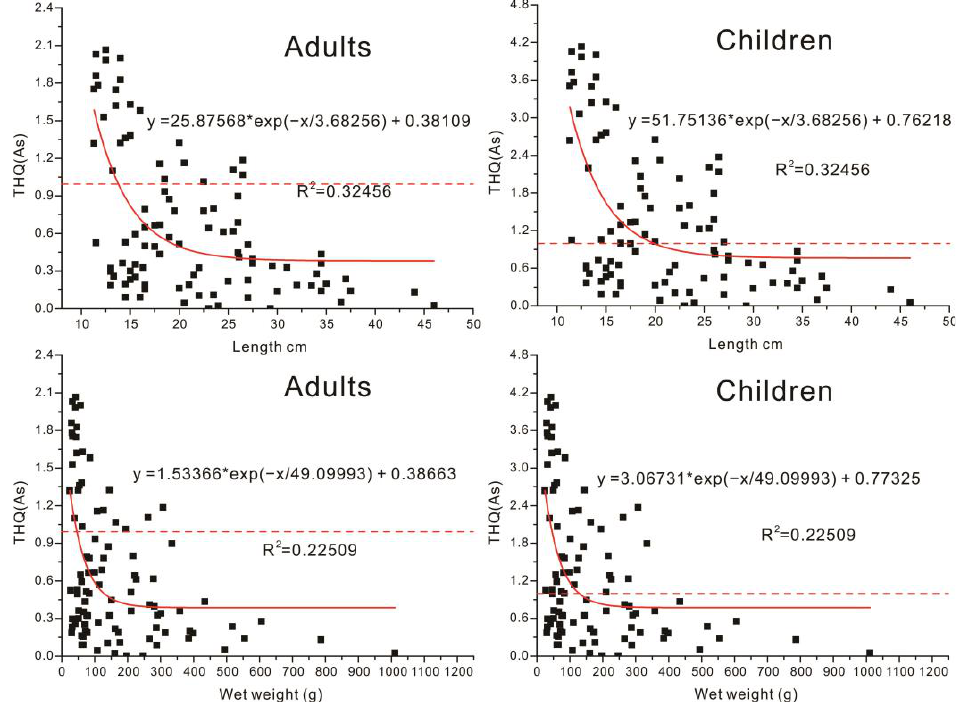
Figure 4. The analysis of regression between length and weight and THQ (As).